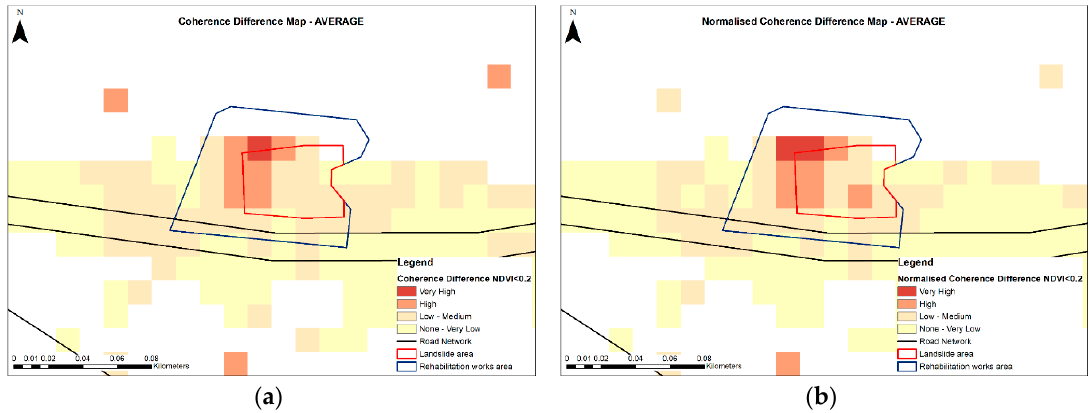
Figure 20. ( a ) Coherence difference and ( b ) normalized coherence difference maps – Average.